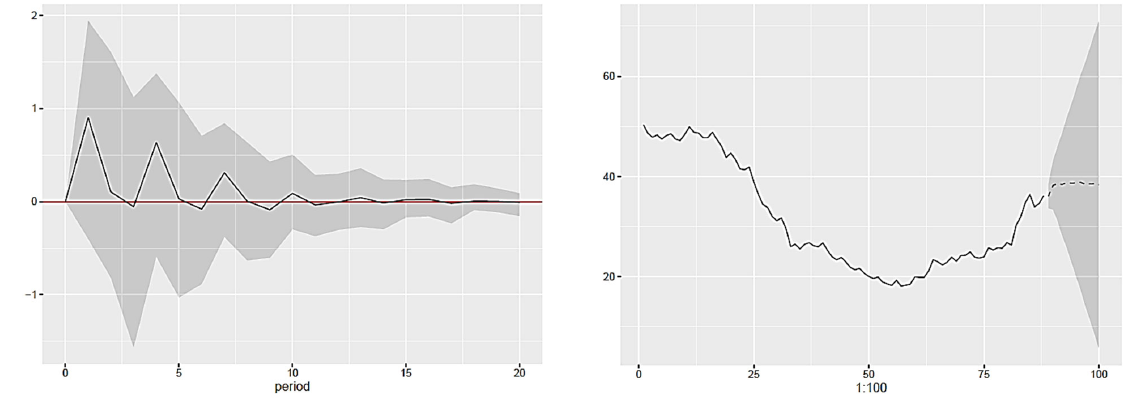
Fig. 3. Impulse-response function d to g Fig. 4. Public debt forecast